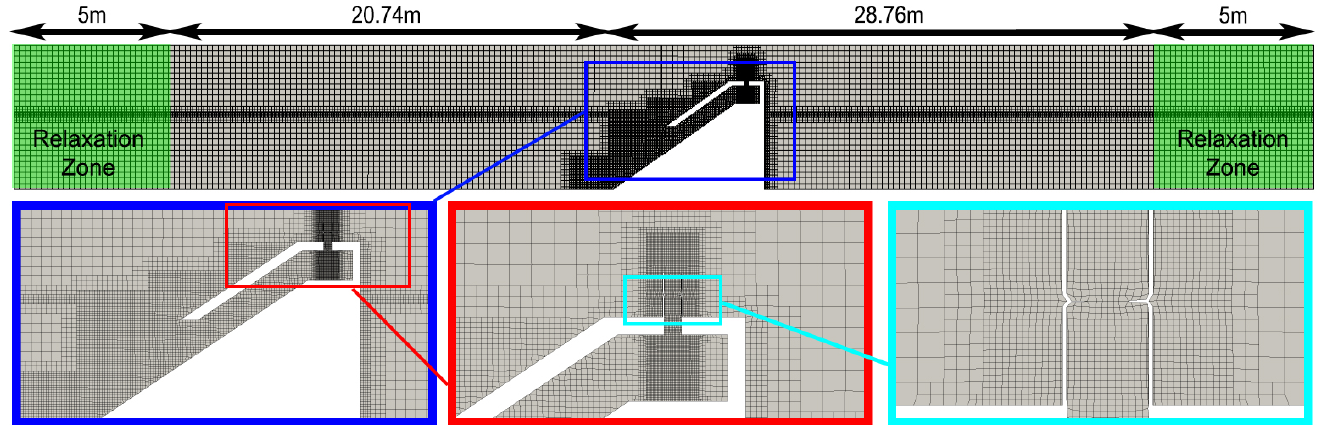
Figure 18. OpenFOAM computational domain and grid refinement regions for the wave regimes, the duct, and the